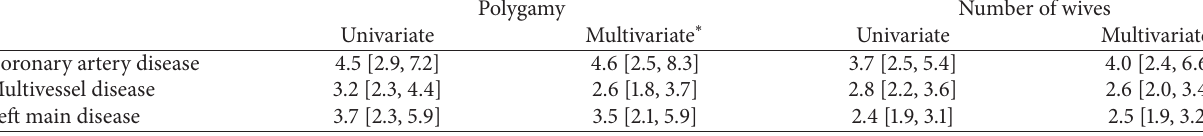
Table 3: Association of number of wives and polygamy with coronary artery disease in univariate and multivariate logistic